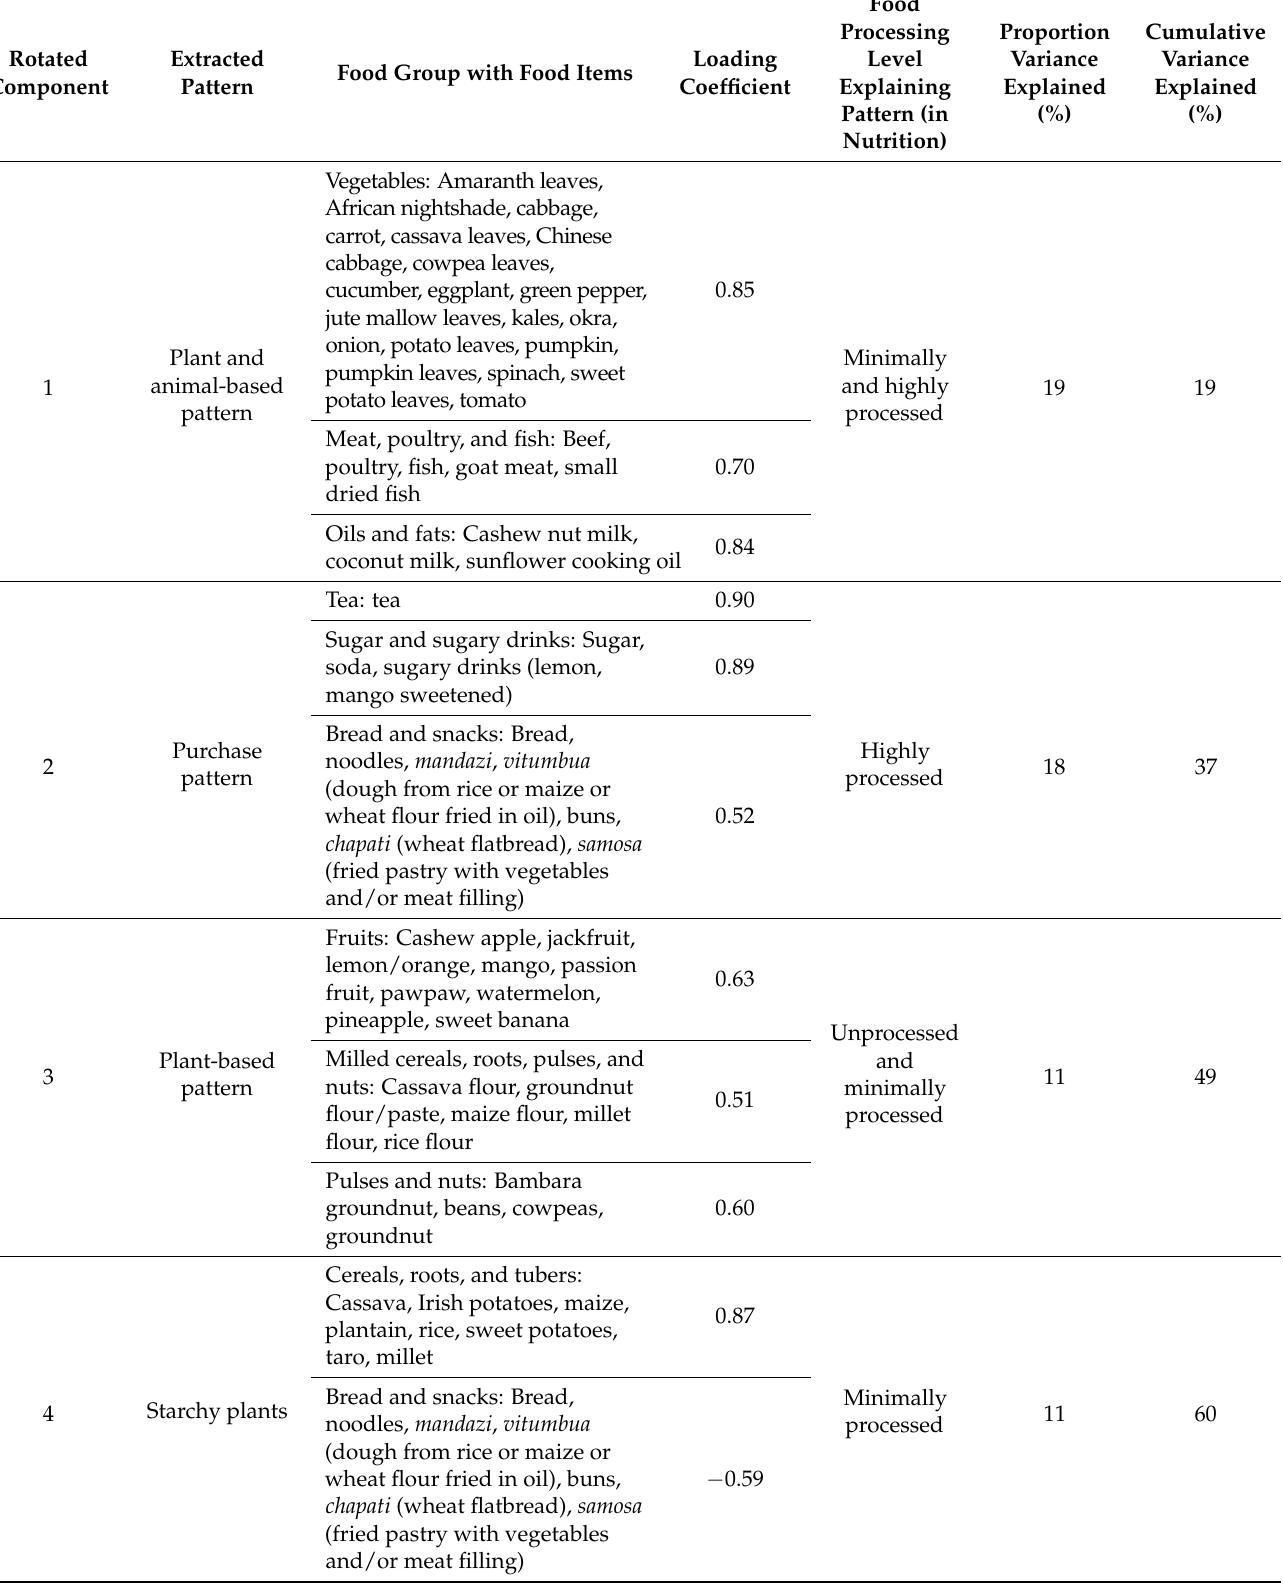
Table 4. Patterns extracted for women of reproductive age in Tanzania based on 11 food groups and characterized by three food processing